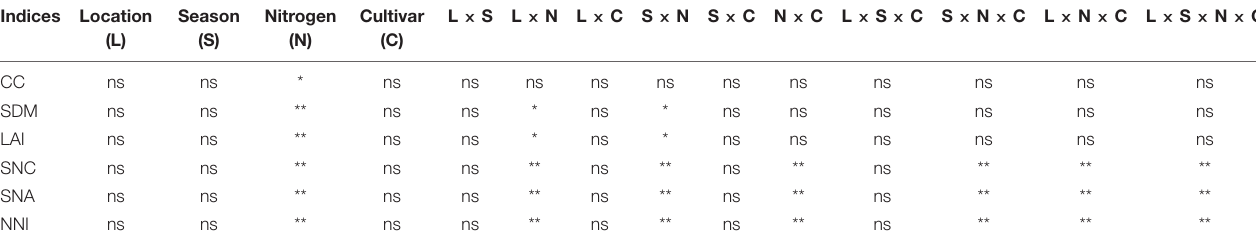
TABLE 3 | The variance analysis of canopy cover, shoot dry matter, leaf area index, shoot nitrogen concentration, shoot nitrogen accumulation, and nitrogen nutrition index for location, season, nitrogen, cultivars, and their possible interactions. Indices Location